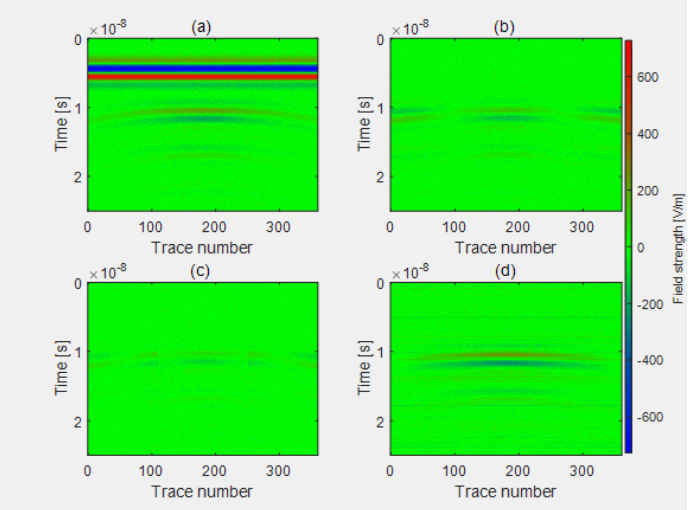
Figure 10. The visual results from simulated dataset. ( a ) Raw data image. ( b ) Mean subtraction method. ( c ) Moving average method. ( d ) Proposed CCBS method. By comparison, the